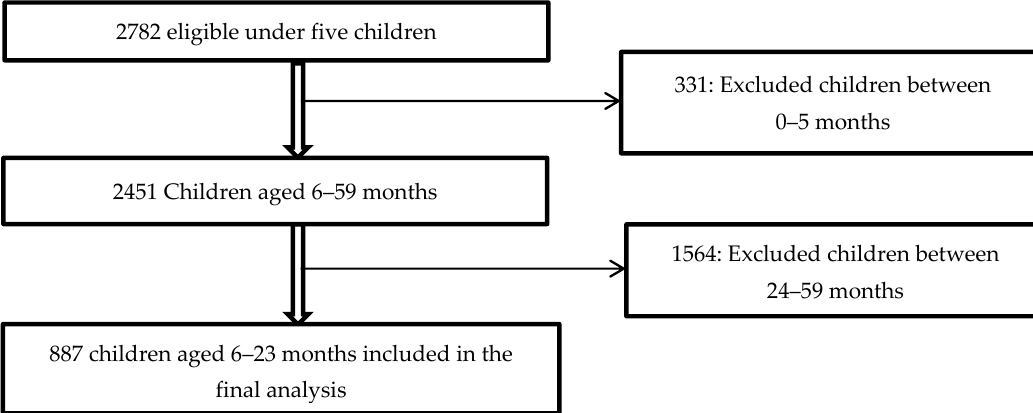
Figure 2. Participant flow chart.